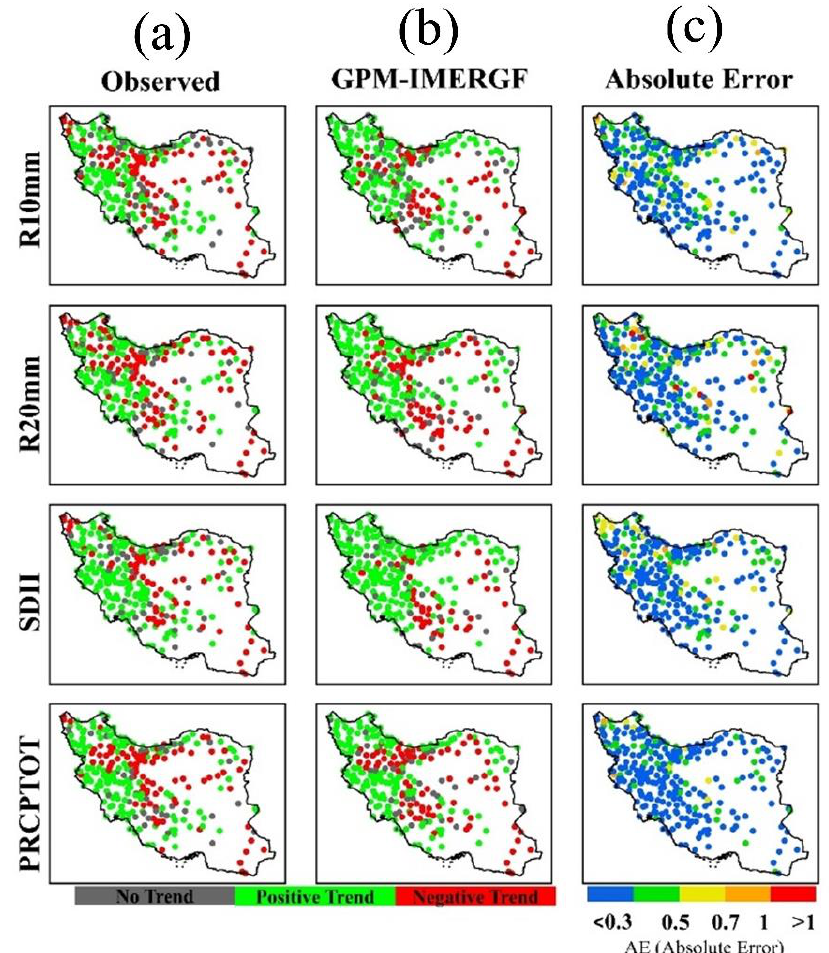
Figure 10. Absolute precipitation indices trends based on GPM-IMERGV6.0 Final Run (GPM- IMERGF) data and observational data. ( a – c ) are observational trends, GPM-IMERGF estimated trends, and absolute error between estimated Tau Kendall (Z score) and observed ones, respectively.